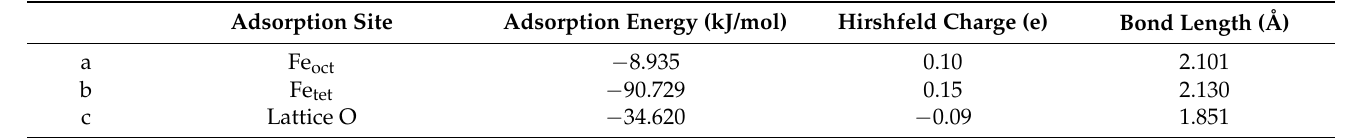
Figure 1. Stable adsorption configurations of NH 3 on Fe tet site ( a ), Fe oct site ( b ), and Lattice O site ( c ) of the γ -Fe 2 O 3 (111) surface (N, blue; Fe, purple; H, white; O, red). Table 1. The parameters of optimized configurations of the γ -Fe 2 O 3 (111) surface-adsorbed NH 3